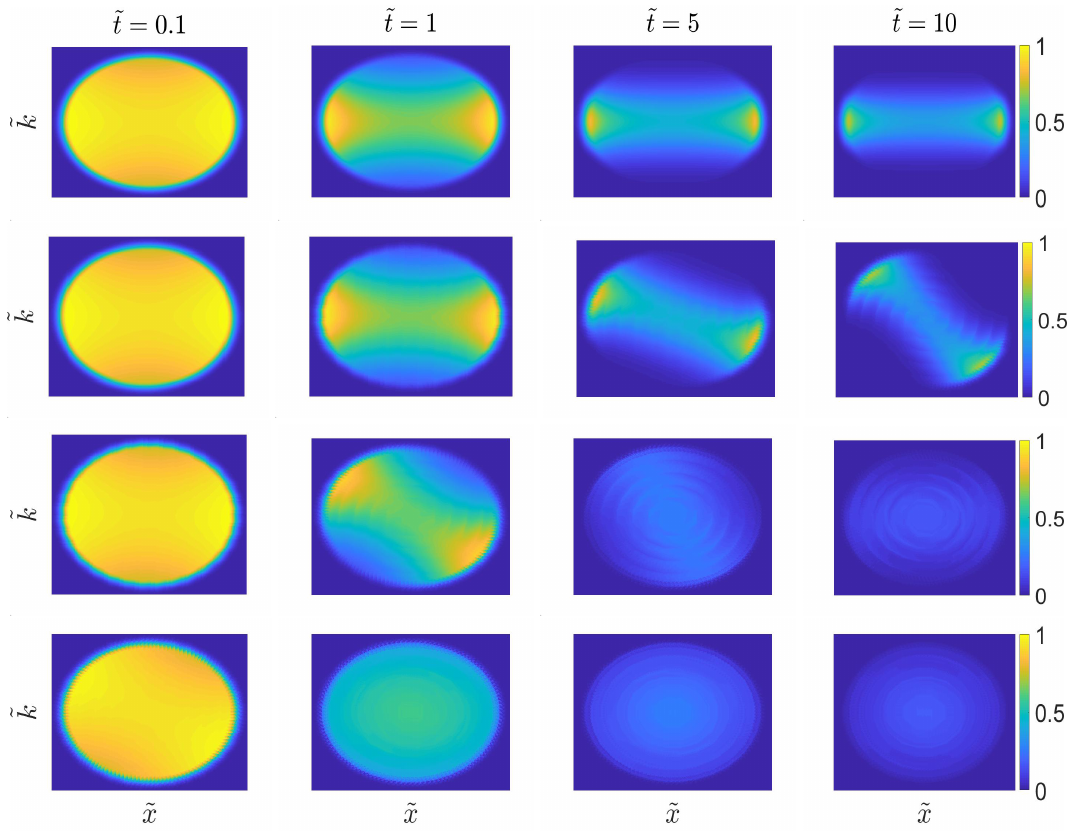
Figure 2: Snapshots of the density function f ( ˜ x ,˜ k , ˜ t ) in the ˜ x − ˜ k phase space for different values of ˜ t = 0.1, 1, 5 and 10. Starting from the first row to the fourth one we set ω/ ˜ Γ = 0, ω/ ˜ Γ = 0.1, ω/ ˜ Γ = 1 and ω/ ˜ Γ = 10, respectively. The circle where f ( ˜ x ,˜ k , ˜ t ) is different from zero has unit radius (ticks not shown). Spirals are a numerical artefact due to the discretisation of the phase space, for further details see Appendix